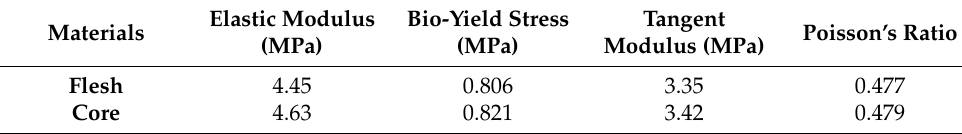
Table 1. Average value of carrot elastic-plastic material